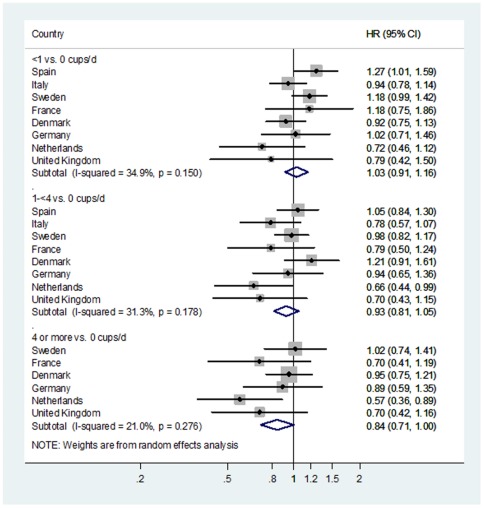
Association between tea consumption as a categorical variable (>0-<1 vs. 0, 1-<4 vs. 0, ≥4 vs. 0 cups/d) based on data from a food frequency questionnaire and risk of type 2 diabetes (n = 26,039).Country-specific Hazard Ratios (HR) and 95% Confidence Intervals (95%CI) were pooled using random effects meta-analyses. HR were adjusted for sex, smoking status, physical activity level, education level, intake of energy, protein, carbohydrates, saturated fatty acids, mono-unsaturated fatty acids, poly-unsaturated fatty acids, alcohol, fiber, coffee, juices, soft-drinks, milk, and body mass index.